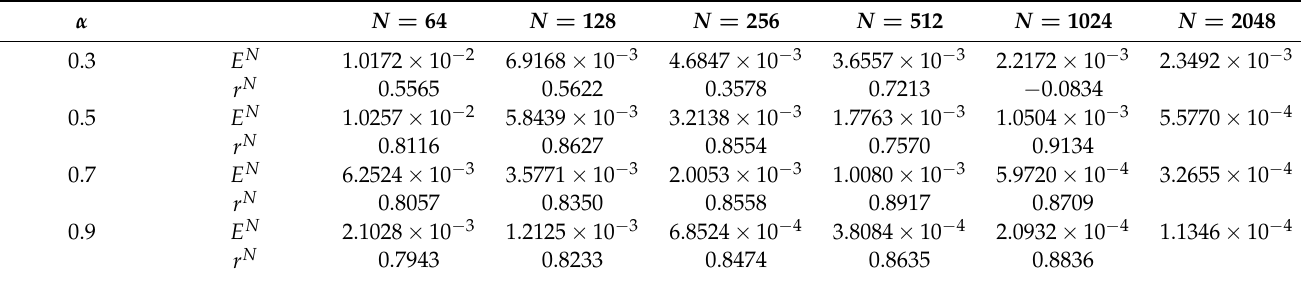
Table 1. Numerical results using arc-length monitor function [26].